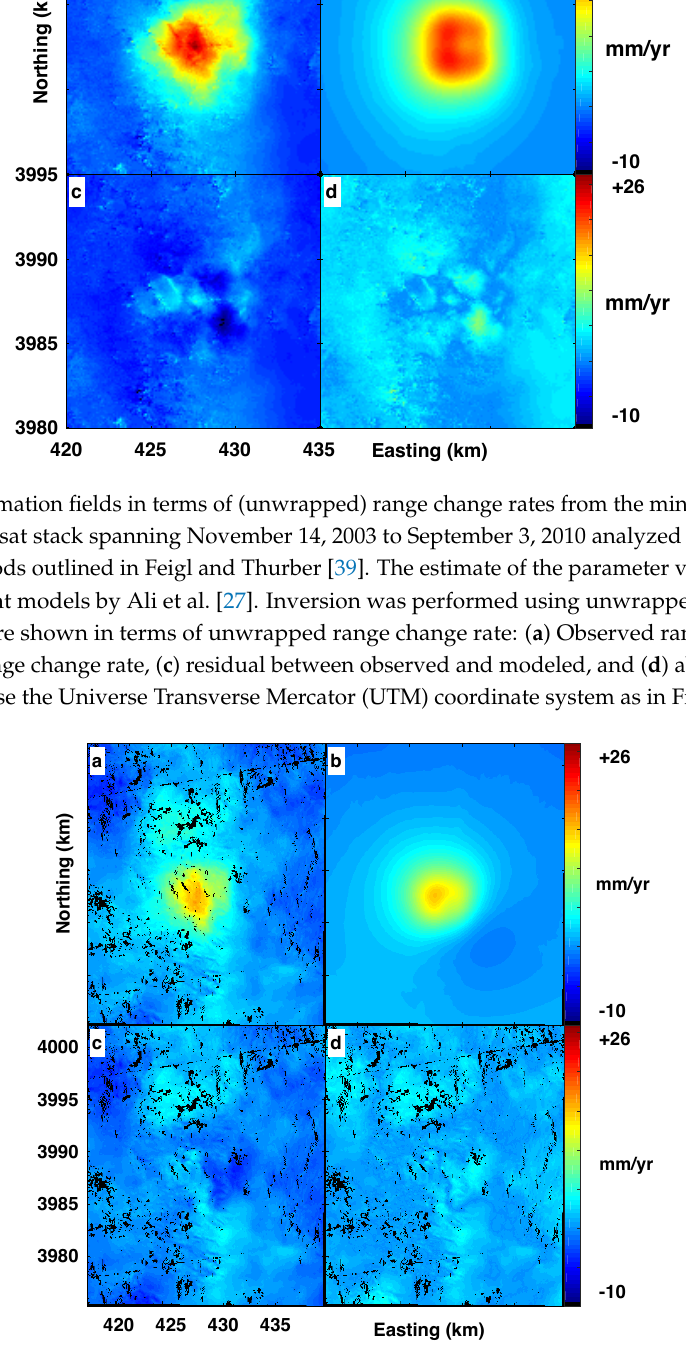
Figure 10. Deformation fields in terms of (unwrapped) range change rate from the Sentinel-1A stack spanning November 3, 2014 to April 26, 2016 analyzed using nonlinear inversion methods outlined in Feigl and Thurber [39]. The estimate of the parameter vector was based on finite element models by Ali et al. [27]. Inversion was performed using unwrapped range change rates. Results are shown in terms of unwrapped range change rate: ( a ) Observed range change rate, ( b ) modeled range change rate, ( c ) residual between observed and modeled, ( d ) and absolute value of residuals. We use the UTM coordinate system as in Figure